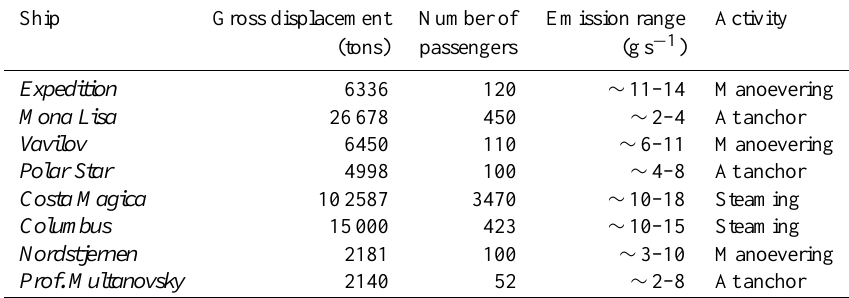
Table 2. SO 2 emission rates (fluxes) (gs − 1 ) from seven ships measured within Kongsfjord, Ny Ålesund either steaming or at anchor. Passenger numbers are indicative only, it is not known whether the ships were at their carrying capacity. No information on the engines or their settings was available at the time of the measurements.